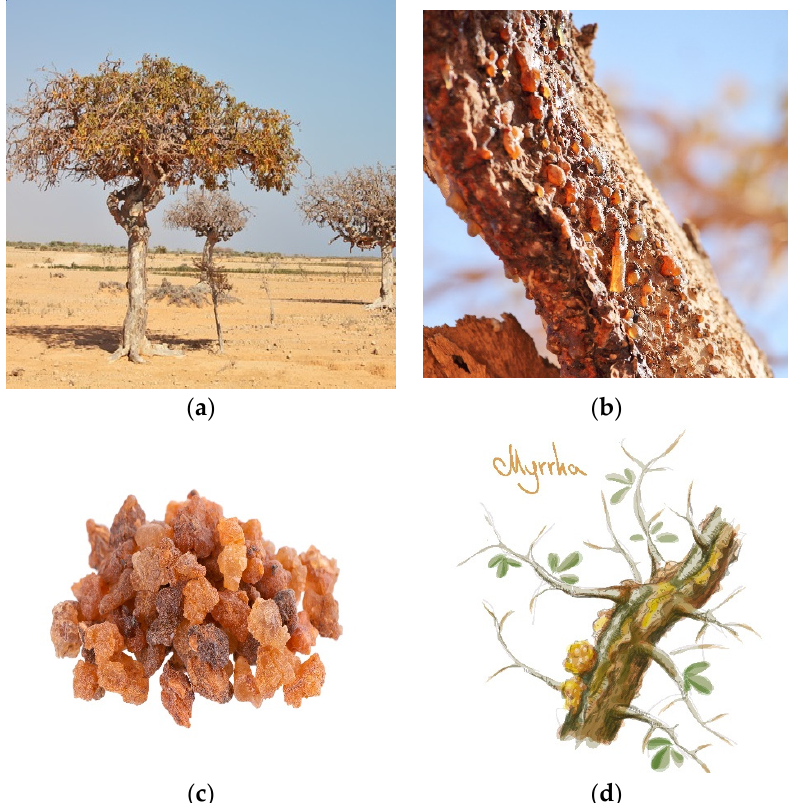
Figure 1. ( a ) Commiphora myrrha tree; ( b ) resin appears from the tree trunk; ( c ) C. myrrha resin; ( d ) illustration of C. myrrha plant. All pictures and illustrations do not have any copyright issues.